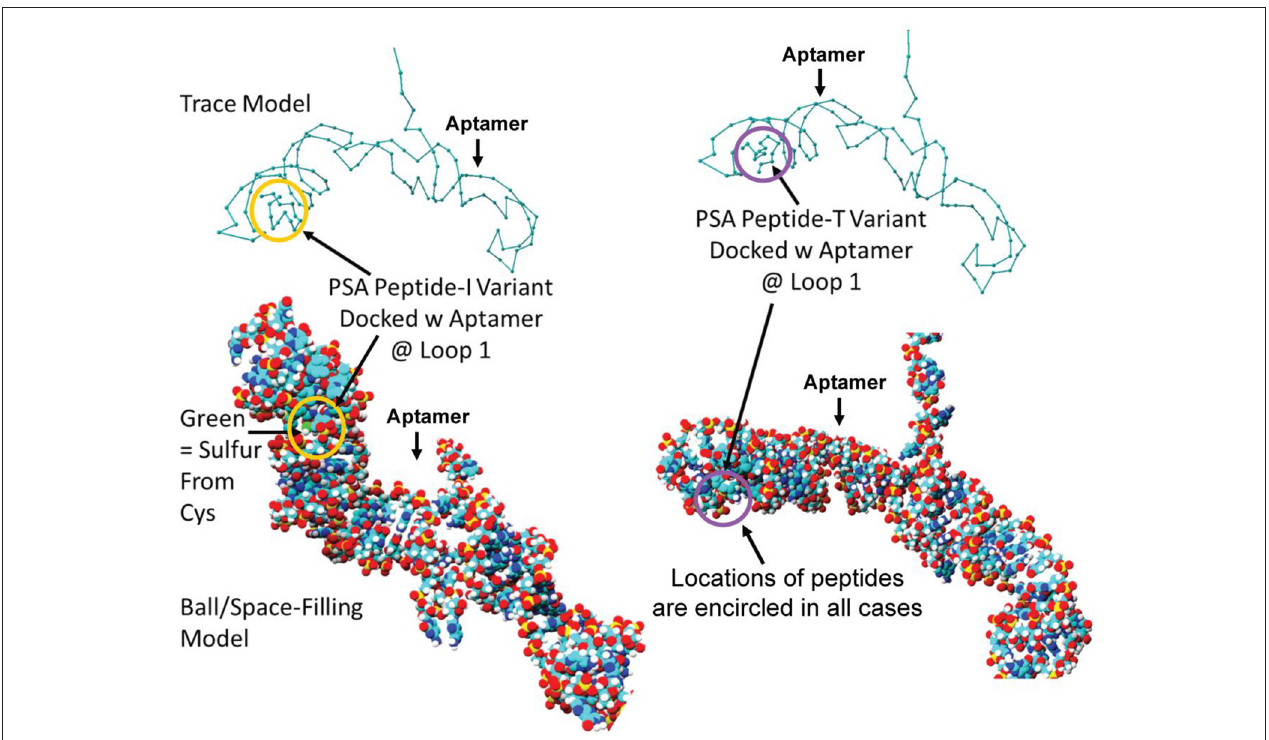
FIGURE 5 | Results of initial YASARA-based 3-D molecular modeling to identify where the PSA variant isoleucine (I) vs. threonine (T) peptide regions bound to the candidate aptamer. Top—trace models of the aptamer docked with the two variant PSA peptides reveal binding to the same loop structure. Bottom − 3-D space-filling ball models of the same binding events. Peptides are encircled in each case to distinguish their locations within the loop structure designated Loop 1 in the docked aptamer-ligand complexes.